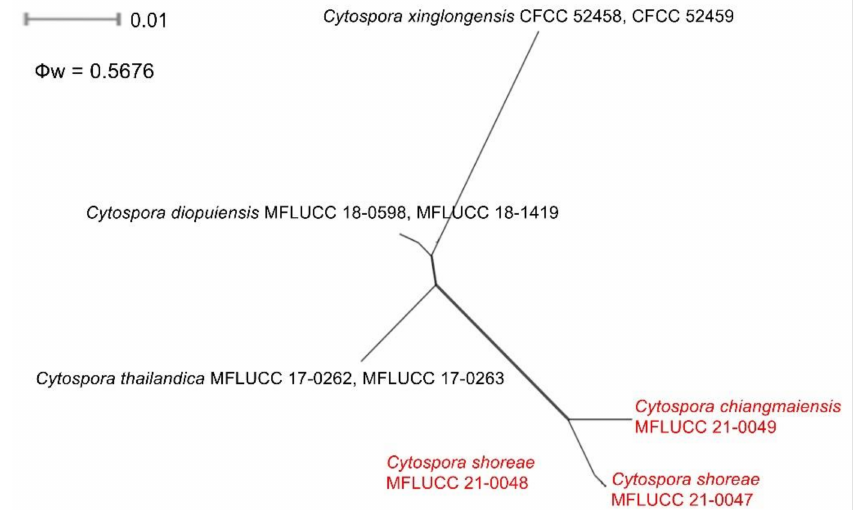
Figure 3. Results of the pairwise homoplasy index (PHI) test of Cytospora chiangmaiensis and C. shoreae and closely related species using both LogDet transformation and splits decomposition. PHI